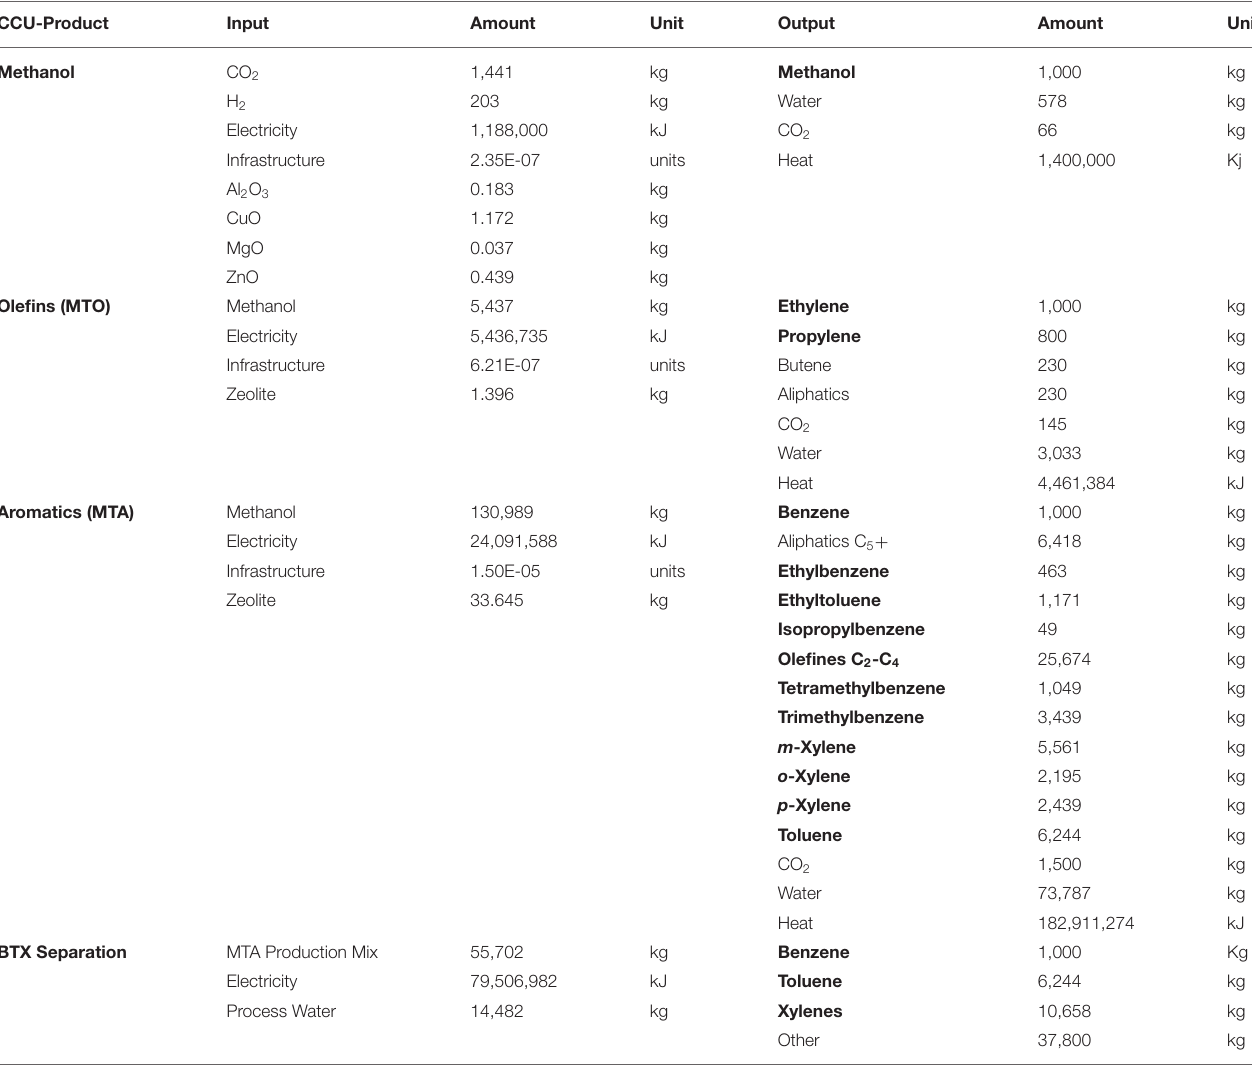
TABLE 2 | Input and output metrics of chemical synthesis modules producing 1,000kg of the respective product.